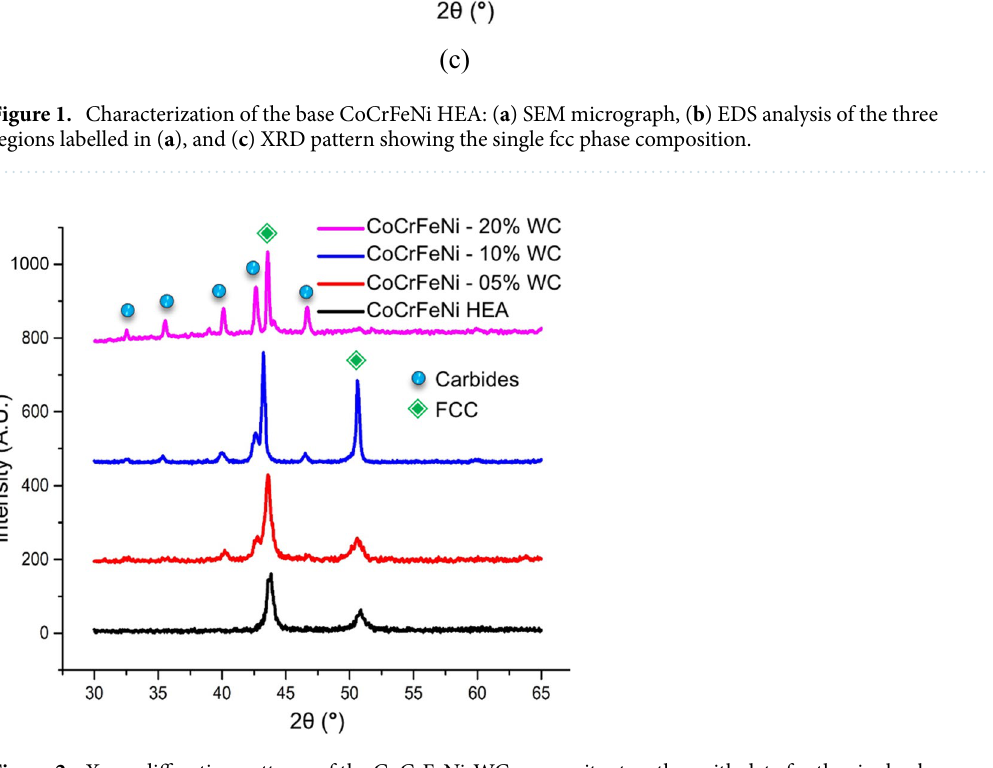
Figure 2. X-ray diffraction patterns of the CoCrFeNi-WC composites together with data for the single phase CoCrFeNi